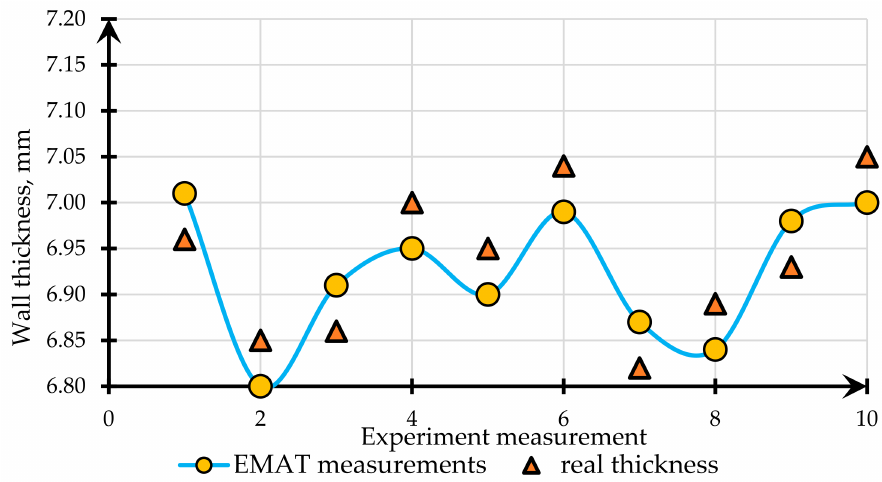
Figure 14. Results of the comparison of EMAT thickness measurements with their real values.